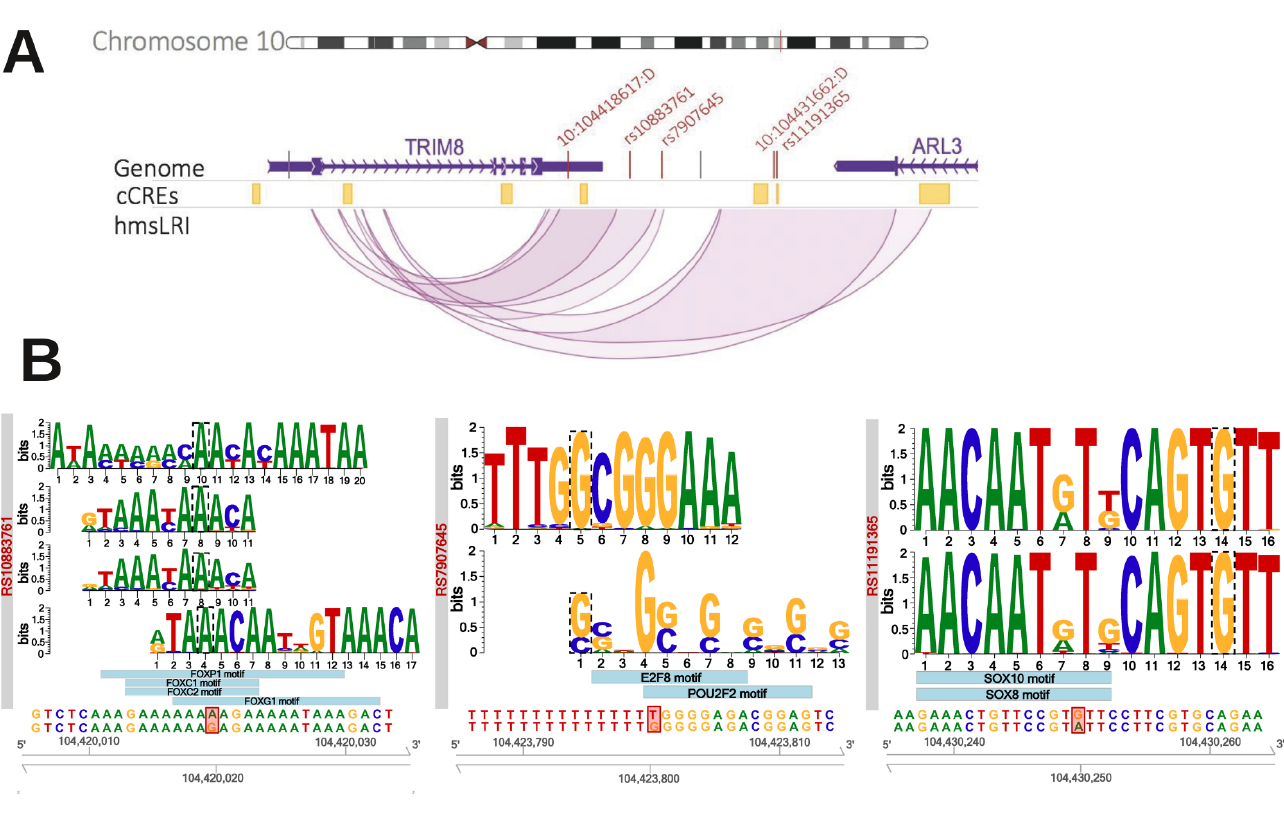
Figure 5. (A) GWAS-identified risk variants associated with schizophrenia overlap with five dif- ferent hmsLRI-E connected with the TRIM8 gene. Visualization of the human TRIM8 - ARL3 locus, located on 10q24.32. In the middle track, in yellow, cCREs identified by (Li et al., 2021) [11] lifted over to the human genome. In the lower track, our hmsLRI: enhancers are represented in their full length, while promoter as their middle point. In the top genome track, vertical bars represent SNPs associated to schizophrenia according to (Li et al., 2021) [11]; the ones shown in red fall into one of our hmsLRI-E connected to the TRIM8 promoter. (B) Neural TF binding site alteration by the risk variants. Alteration by the risk variants of putative neural TF binding sites, as predicted by motifbreakR (Coetzee et al., 2015) [22]. From below upwards: reference DNA sequence and SNP alteration, highlighted in red; light blue boxes represent motifs of transcription factors whose binding is predicted to be strongly influenced by the SNP; detail of the binding motif, retrieved from ENCODE. The motif nucleotide affected by the SNP is surrounded by a dotted line; if the nucleotide is the same as the reference genome, the binding site is predicted to be lost, otherwise it is gained: rs10883761 and rs1191365 disrupt potential binding sites of the TF represented, while rs7907645 leads to the acquisition of the indicated potential novel TF binding